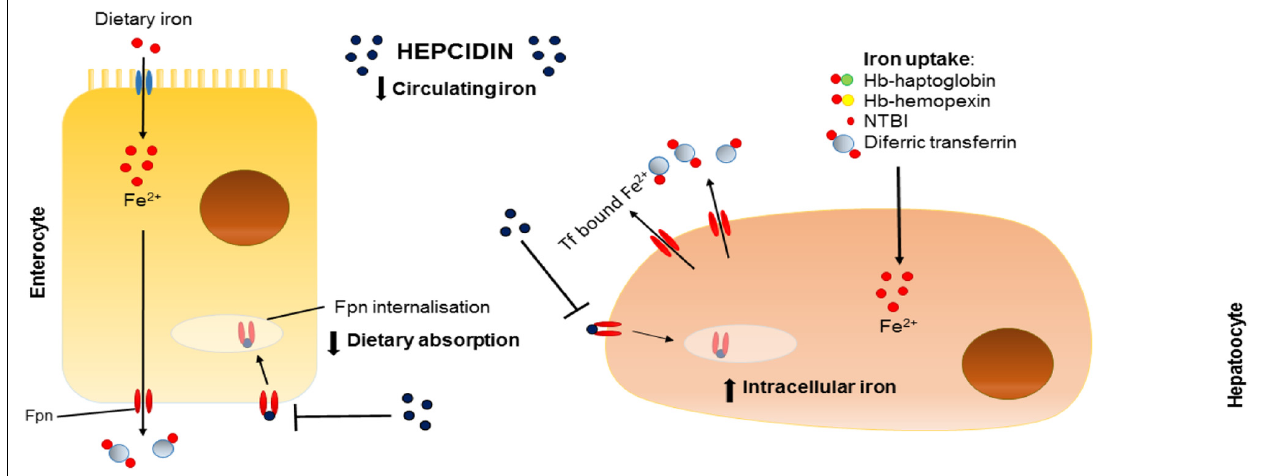
FIGURE 1 | Effects of hepcidin on iron homeostasis. Schematic representation of the effects of hepcidin on dietary absorption of iron (left) and intracellular iron stores (right). Fpn, ferroportin; Tf, transferrin; Fe, iron; Hb, hemoglobin; NTBI, non-transferrin-bound iron.